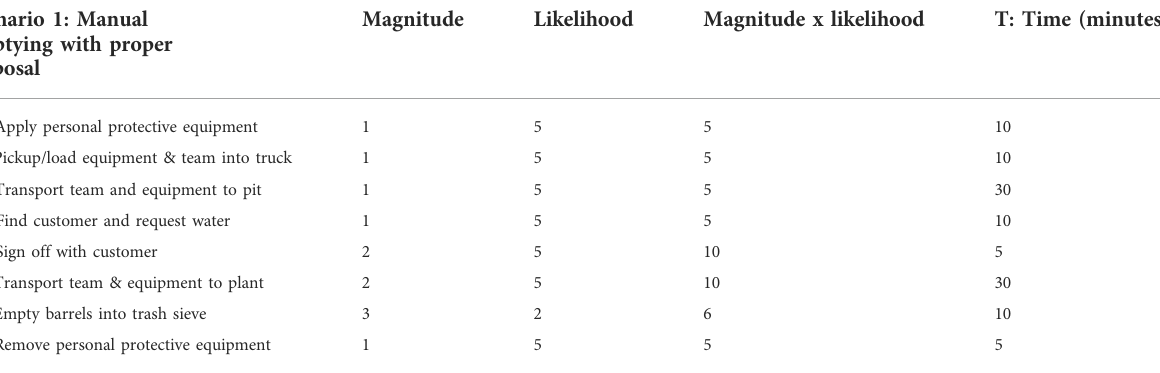
TABLE1Scenario1,Excerptoffacialtouchriskscoresformanualemptyingwithproperdisposal.Solidlinesbetweenrowsdenotestoabreakinsteps. See Supplementary Material for the complete set. Scenario 1: Manual emptying with proper